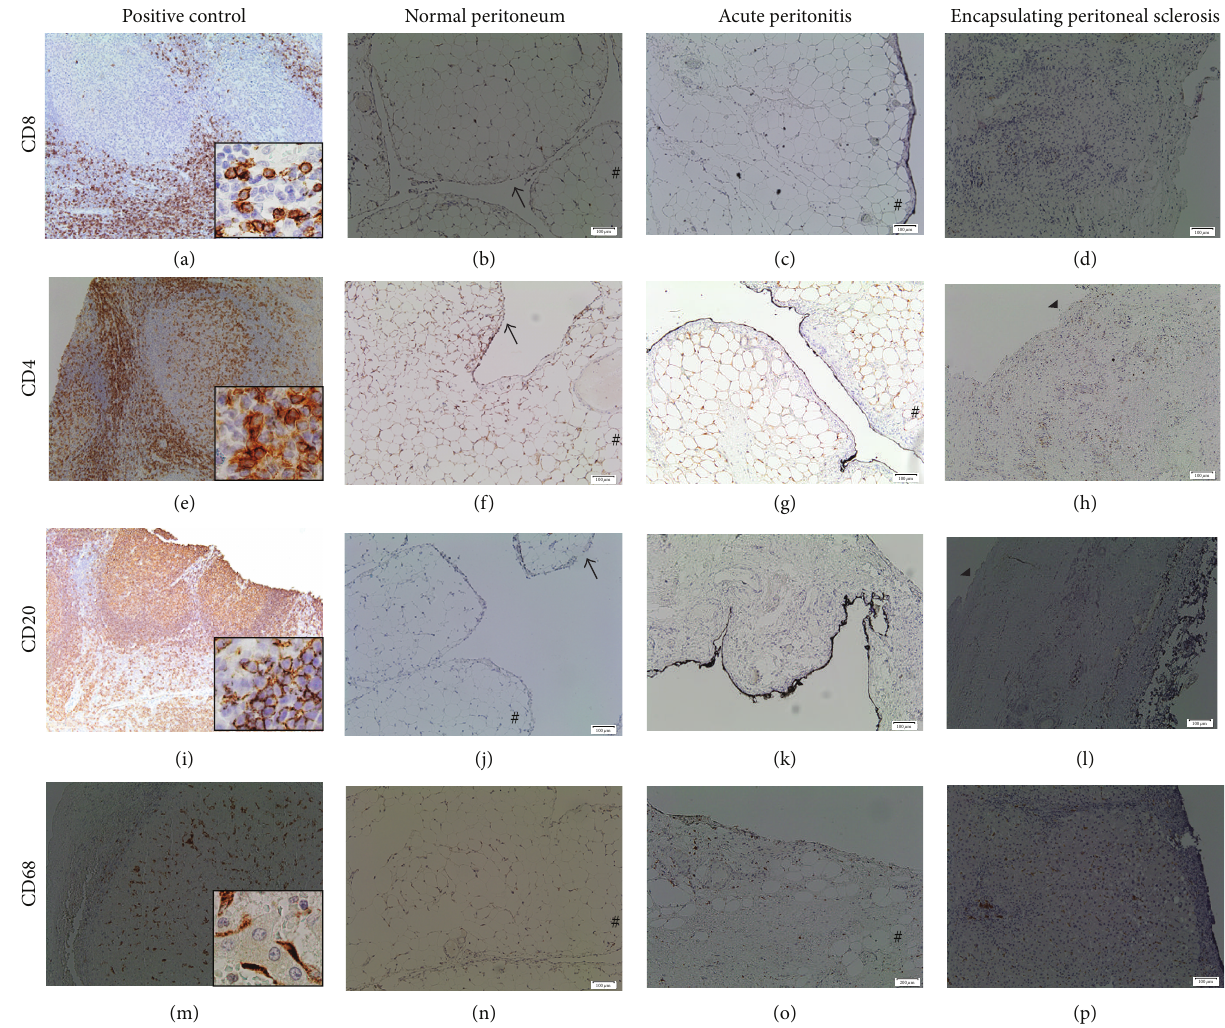
Figure 4: Representative photomicrographs demonstrating histopathological data of interstitial inflammatory cells infiltration in parietal peritoneal tissues biopsy using immunostaining of CD8 (a–d), CD4 (e–h), CD20 (i–l), and CD68 (m–p). Positive control of immunostainings for used antibodies (internal controls) (a, e, i, and m), control: normal peritoneum (b, f, j, and n), case of acute peritonitis (control 3; c, g, k, and o), and case 1 of encapsulating peritoneal sclerosis (EPS) (d, h, l, and p). Absence of mononuclear cells in normal peritoneum. Weak expression of all CD8, CD4, CD20, and CD68 in conjunctive tissue areas adjacent to mesothelium in case with acute peritonitis characterized mainly by polymorphonuclear cells infiltration. Marked interstitial inflammatory cells identified (d) several CD8+ cells (T lymphocytes), (h) few CD4+ cells (T lymphocytes), and (l) CD20+ (B cells), which were accompanied by several (f) CD68+ cells (macrophages) diffusely infiltrating fibrotic areas. Immunoperoxidase staining counterstained with hematoxylin. Original magnification: (a–p) × 20. Small pictures (a, e, i, and m): ×